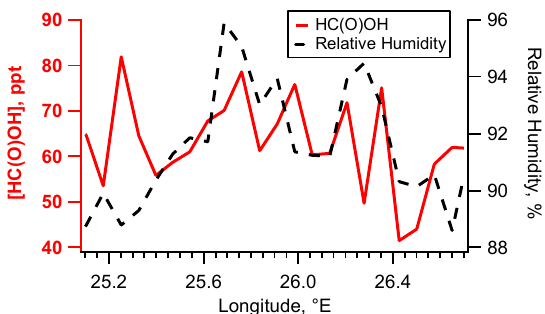
Figure 12. The trend of HC(O)OH concentration (ppt) and relative humidity (%), during the flux measurement period on flight B804 (19 September 2013), between longitudes 25.1° E and 26.7° E along transect x .